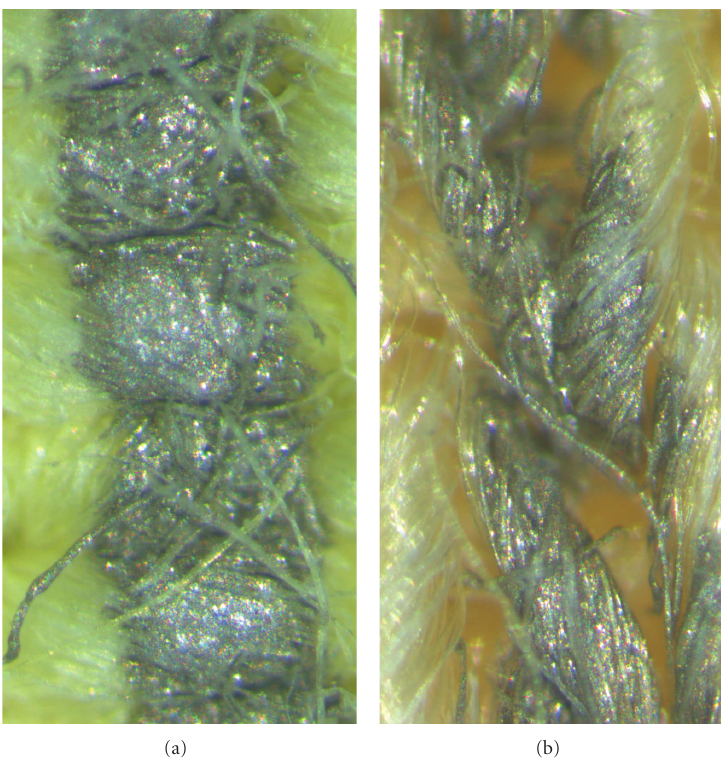
Figure 5: T-match structure on Fabric (A) and Fabric (B), magnification is × 57.